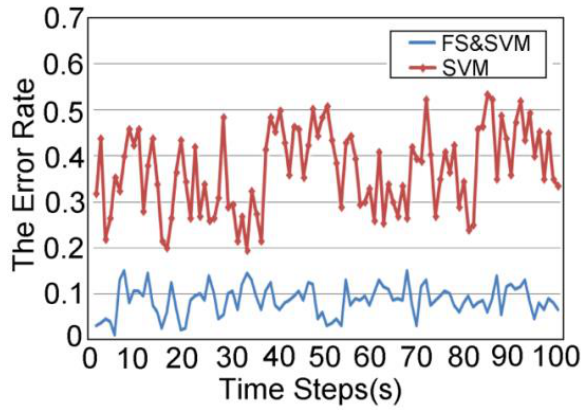
Figure 7. The average recognition error rate for actions in 100